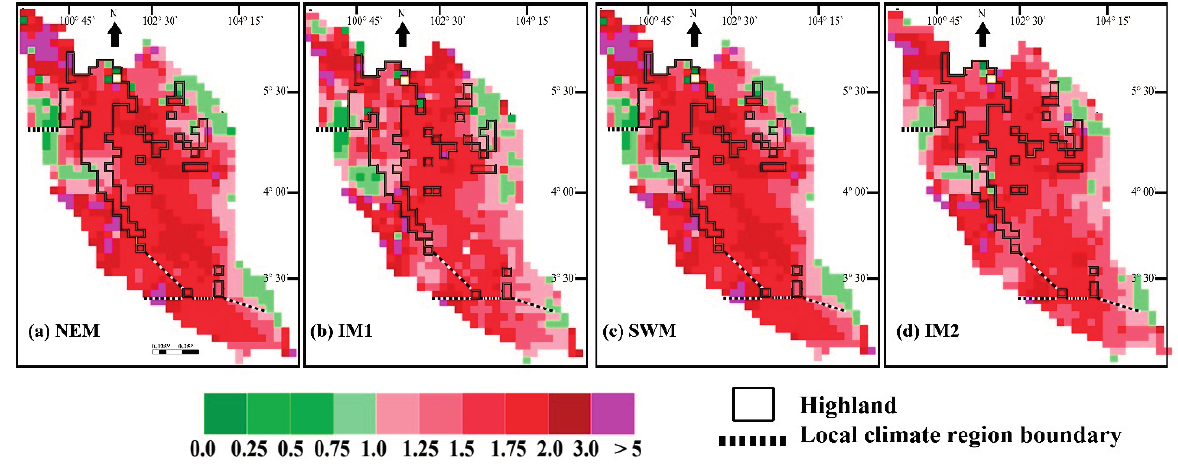
Figure 9. Temporal maps of seasonal ratios of the TRMM 3B43 over ground rainfall. ( a ) NEM: Northeast monsoon, ( b ) IM1: Inter-monsoon 1, ( c ) SWM: Southwest monsoon, ( d ) IM2: Inter-monsoon